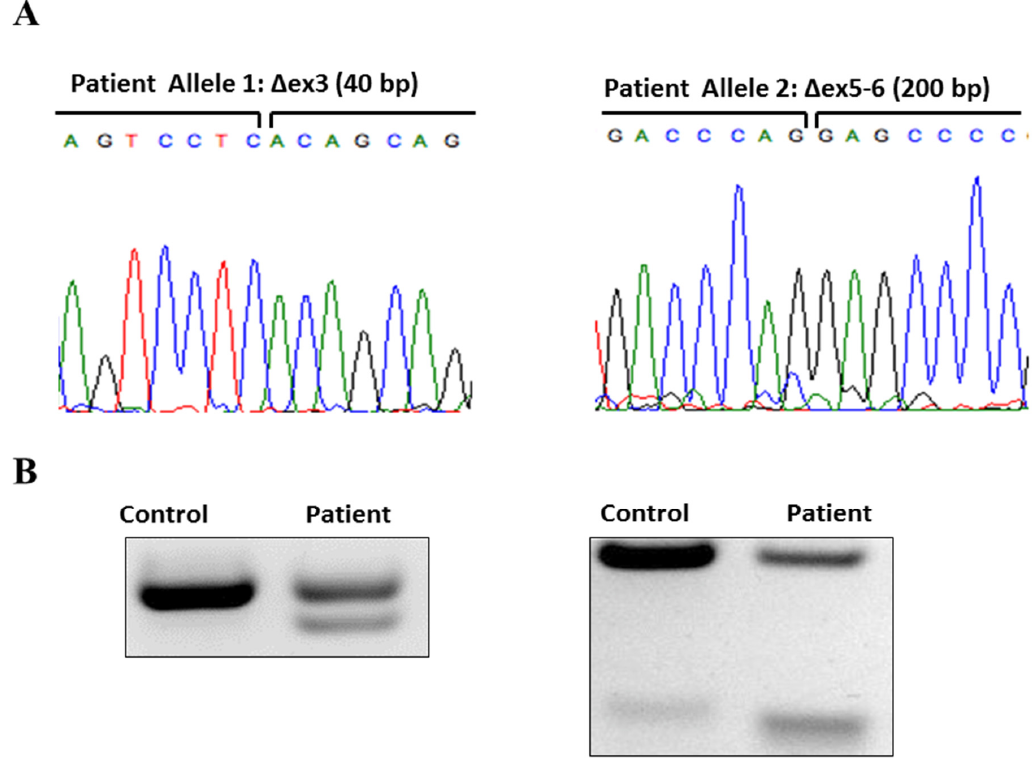
Figure 1. Panel ( A ) shows sequencing of patients’ cDNA generated by RT PCR with deletion in both alleles. Panel ( B ) shows confirmation of heterozygosity in each locus where a control subject has only wild type (normal) band in both analyzed loci; patients’ cDNA shows heterozygosity with wild type and smaller mutant bands. This was also previously published in a modified form as a part of Supplementary data, with the proband denoted “SM” and the younger brother denoted “PM” [18].